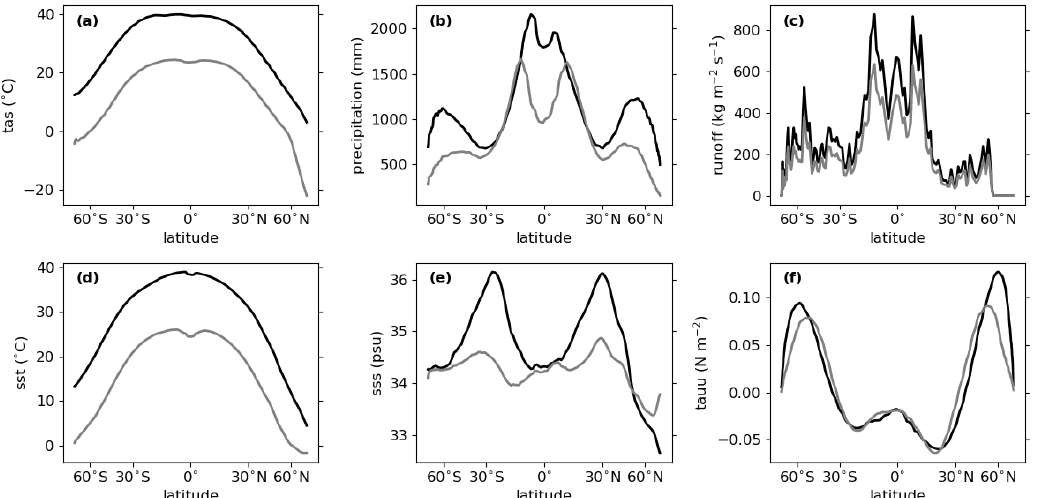
Figure 8. Zonal averages of the supergreenhouse climate in SC-CONST (black) and the Marinoan control climate (grey) for (a) 2m air temperature, (b) precipitation, (c) hydrological discharge from land grid cells, (d) sea surface temperature, (e) sea surface salinity and (f) zonal wind